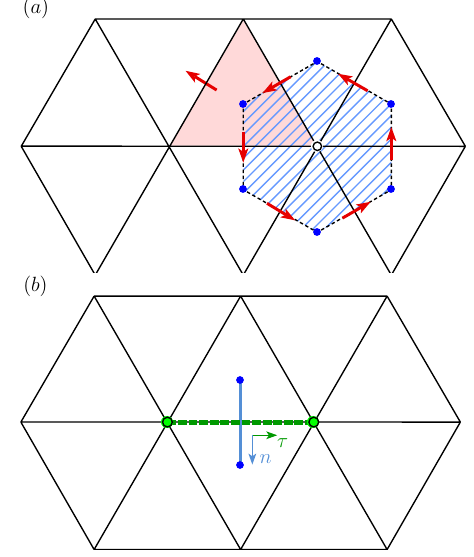
Fig. 2. Schematic showing the stencils of (a) the divergence and curl operators, and (b) the normal and tangential gradient operators described in Sect.